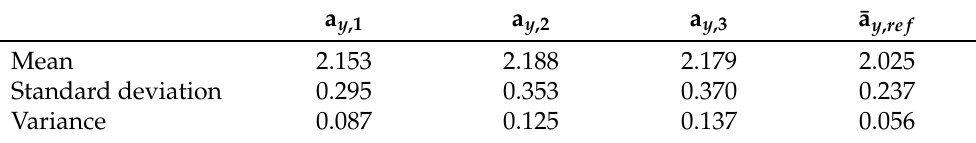
Table 1. Correlation analysis with statistical measures.